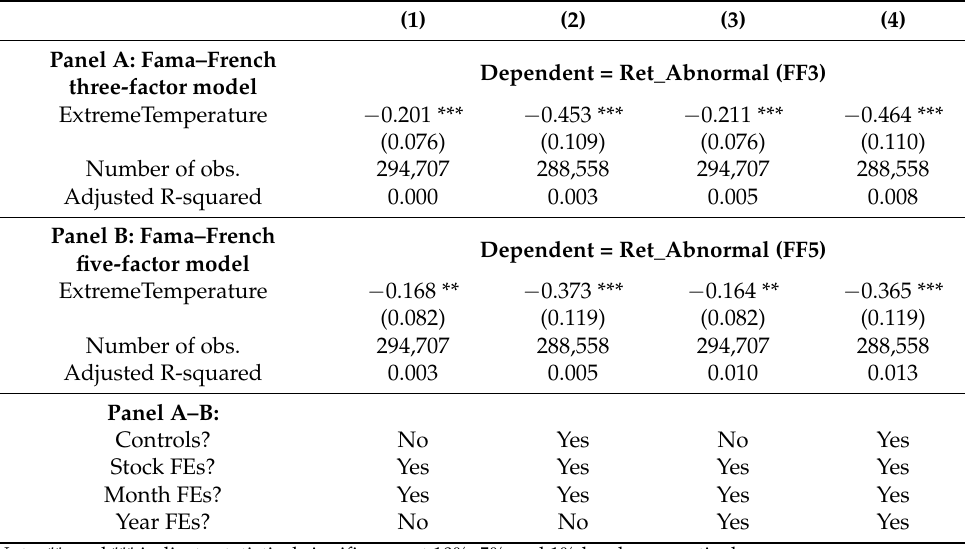
Table 14. Estimating expected returns by using alternative asset pricing models.